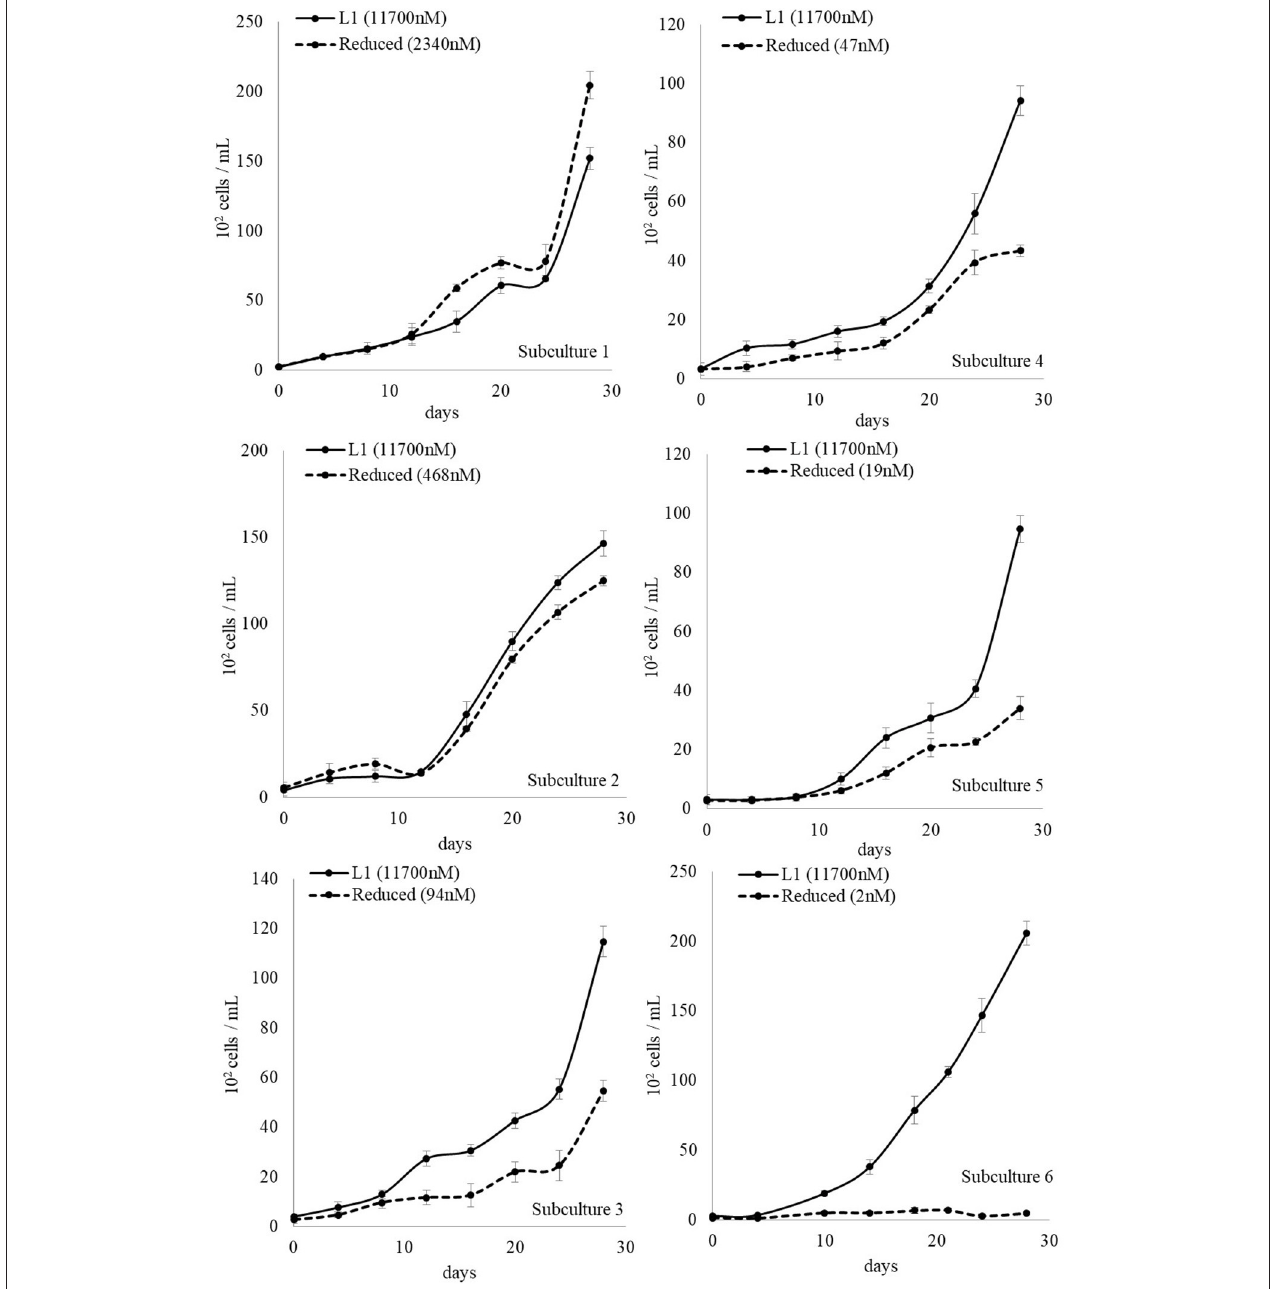
FIGURE 4 | Non-Axenic L. polyedrum growth in L1 media and reduced [Fe] T over 6 subculturings. Solid line: cultures maintained with a [Fe] T at the L1 level throughout the subculturing. Dotted line: cultures where the [Fe] T continually decreased over the subcultures due to dilution.